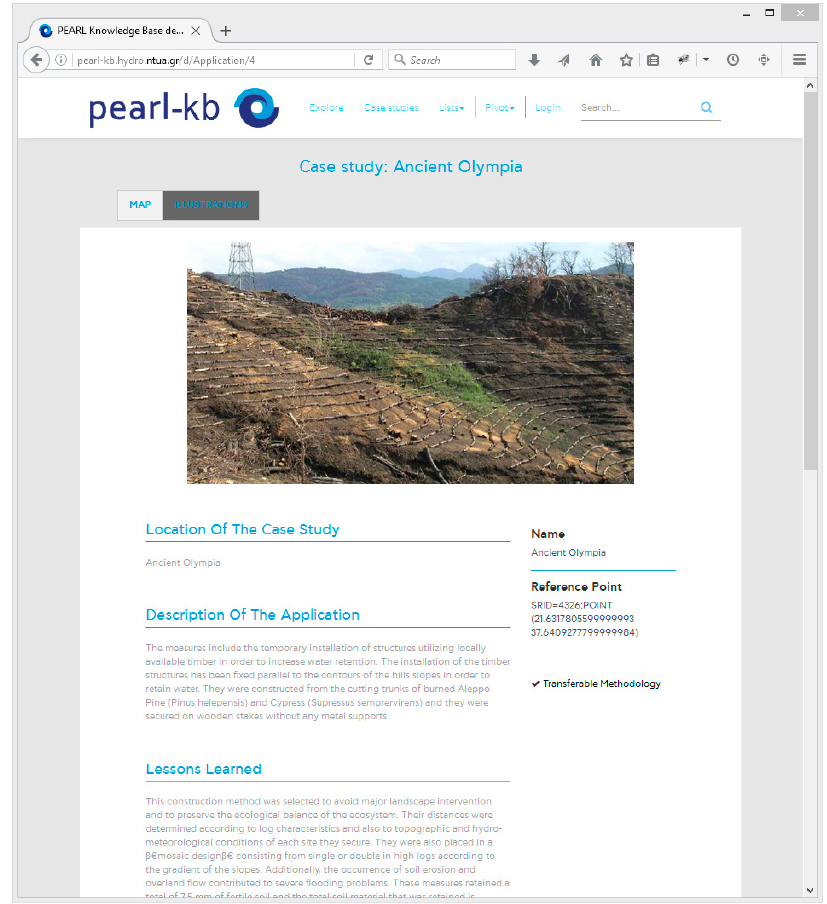
Figure 6 . Example of an object detail page. Figure 6. Example of an object detail